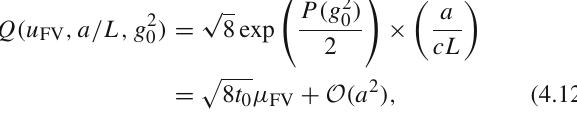
Fig. 8 The product S t of the running factor R and the matching factor Q (see Eq. (4.13)). This has to be constant and equal to 0 discretization errors. The plot shows that these are very small. The error band shows the result of the fit, Eq.